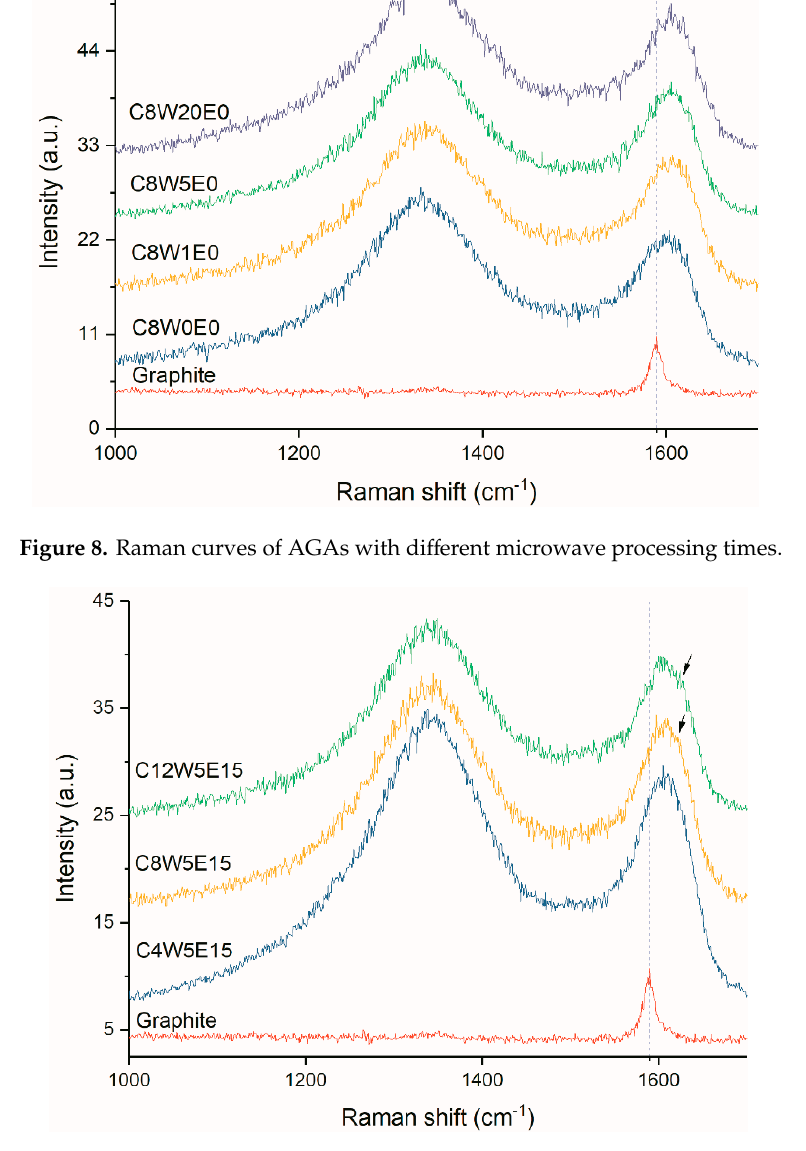
Figure 9. Raman curves of AGAs with different graphene oxide (GO) concentrations (The arrows indicate the blue shift).